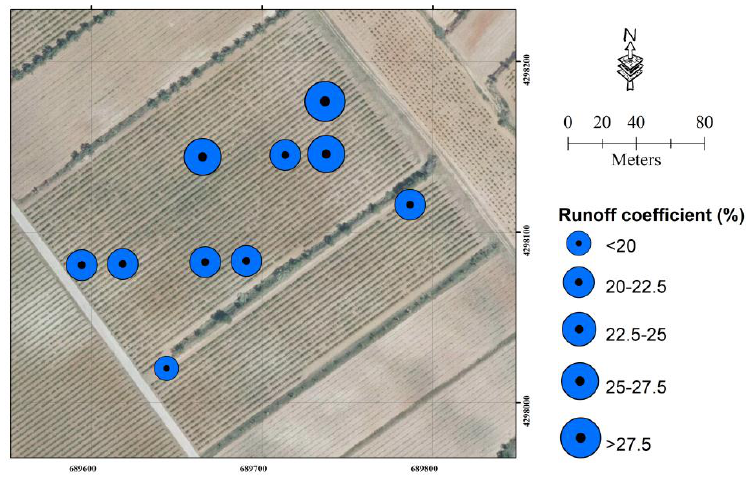
Figure 4. Spatial distribution of runoff coefficient.